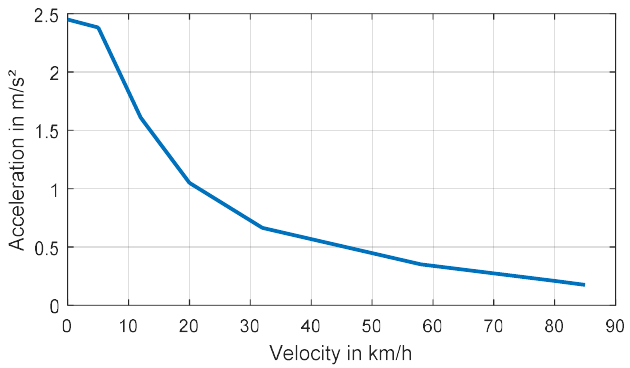
Figure 3. The set acceleration for the semi-trailer truck depending on the actual velocity.